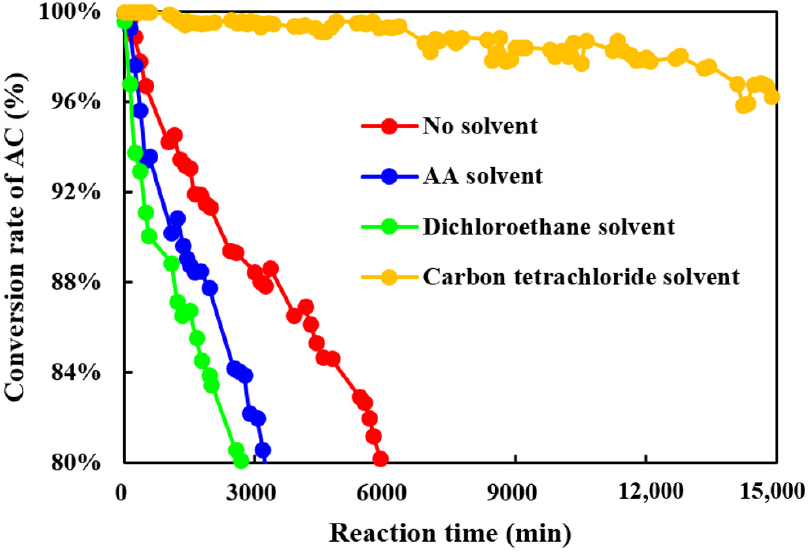
Figure 5. The influence of the solvents on the continuous acylation of